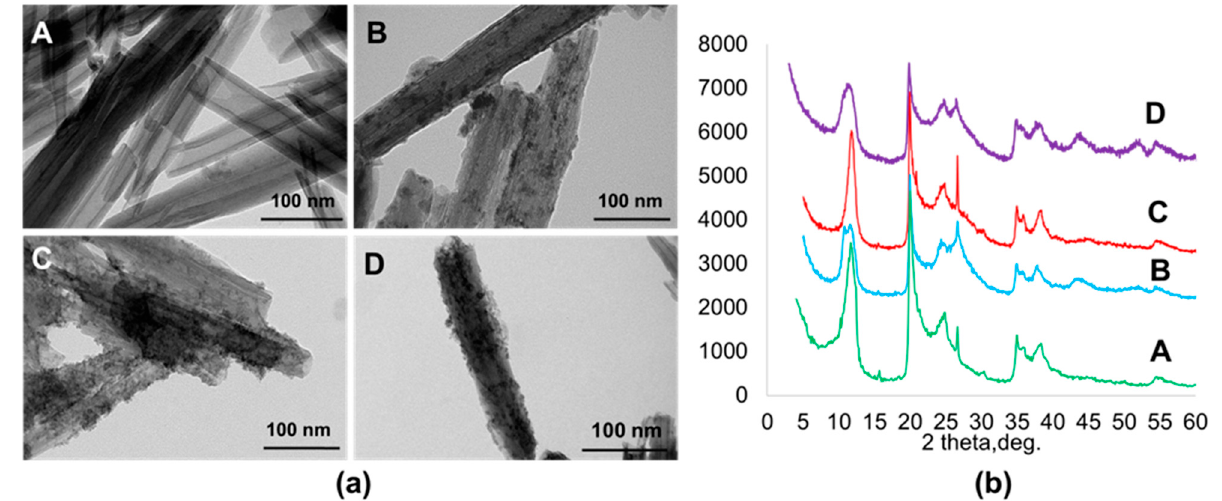
Figure 2. ( a ) TEM image of: A, pristine halloysite; B, CdS/HNT-Azine; C, Cd 0.7 Zn 0.3 S/HNT-Azine; D, CdS/HNT-NH 2 ; ( b ) XRD patterns of: A, pristine halloysite; B, CdS/HNT-Azine; C, Cd 0.7 Zn 0.3 S/HNT-Azine; D, CdS/HNT-NH 2 .